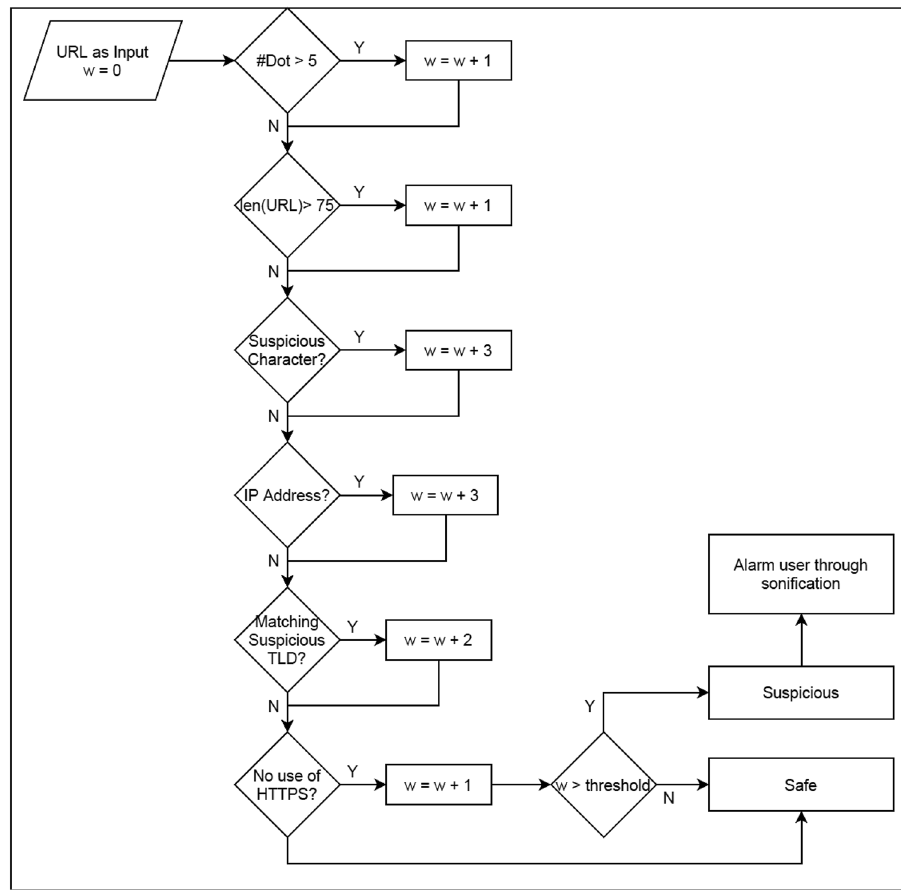
Fig. 3 URL-based